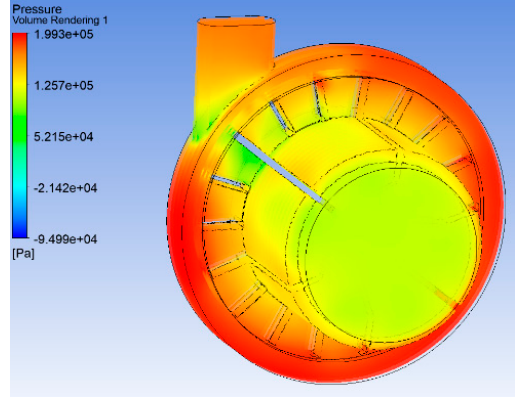
Figure 5. Pressure schedules of the pumped liquid for simulation 4.